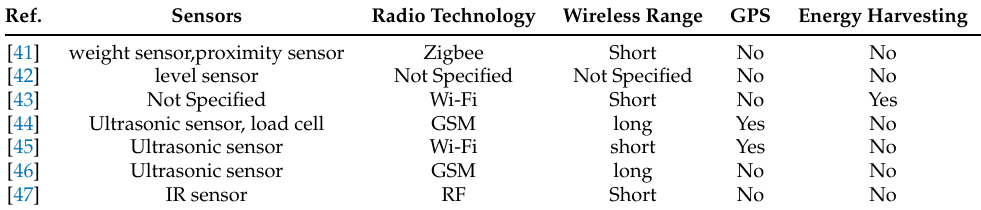
Figure 6. A generic IoT architecture for solid waste handling system. Table 4. Summary of IoT based solid waste handling systems.